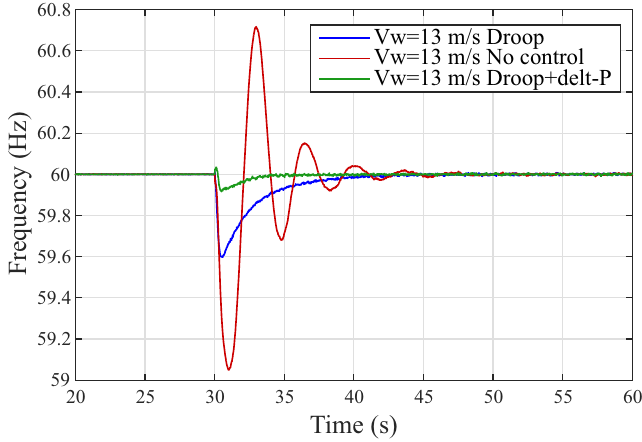
Figure 12. Frequency comparison for wind speed of 13